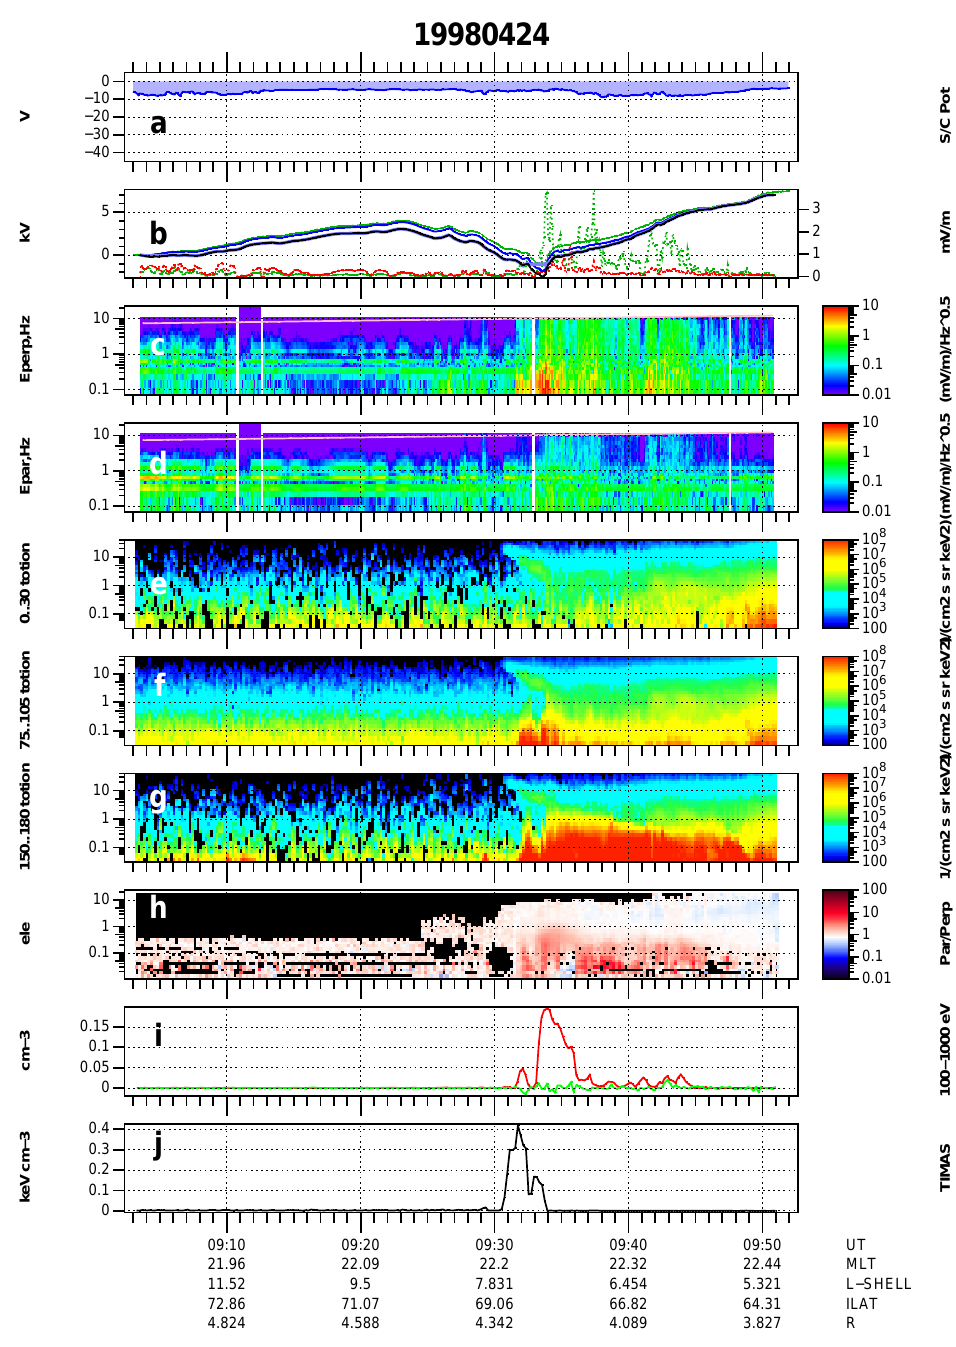
Fig. 2. Polar data for 24 April 1998, 09:05–09:55UT. Panels are named (a)–(j) from top to bottom. (a) Spacecraft potential from the electric field instrument (EFI), (b) EFI Perpendicular electric wave amplitude in frequency range 1–10 Hz as 12-s average (green), parallel wave amplitude (red), plasma potential integrated along satellite trajectory (black), (c) perpendicular wave electric field spectrogram, (d) parallel wave electric field spectrogram, (e) total ion distribution function from TIMAS for 0–30 ◦ pitch angle electrons (downgoing), (f) same for perpendicular ions (75–105 ◦ ), (g) same for antiparallel (upgoing) ions, 150–180 ◦ , (h) ratio of parallel to perpendicular electron distribution function from HYDRA, (i) red line: parallel minus perpendicular electron distribution function integrated between 0.1 and 1 keV (the anisotropic density), green line: up minus down parallel component, positive means upgoing electrons, (j) free energy density in TIMAS ion distribution